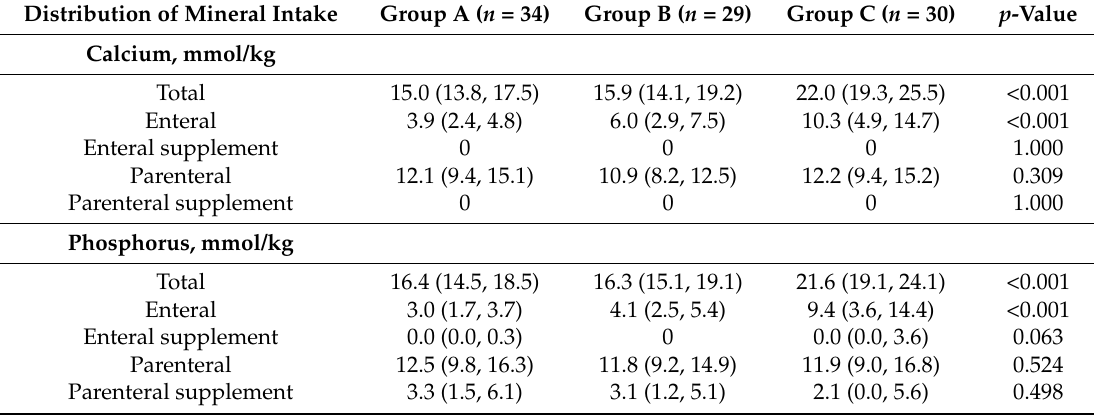
Table A2. Route of